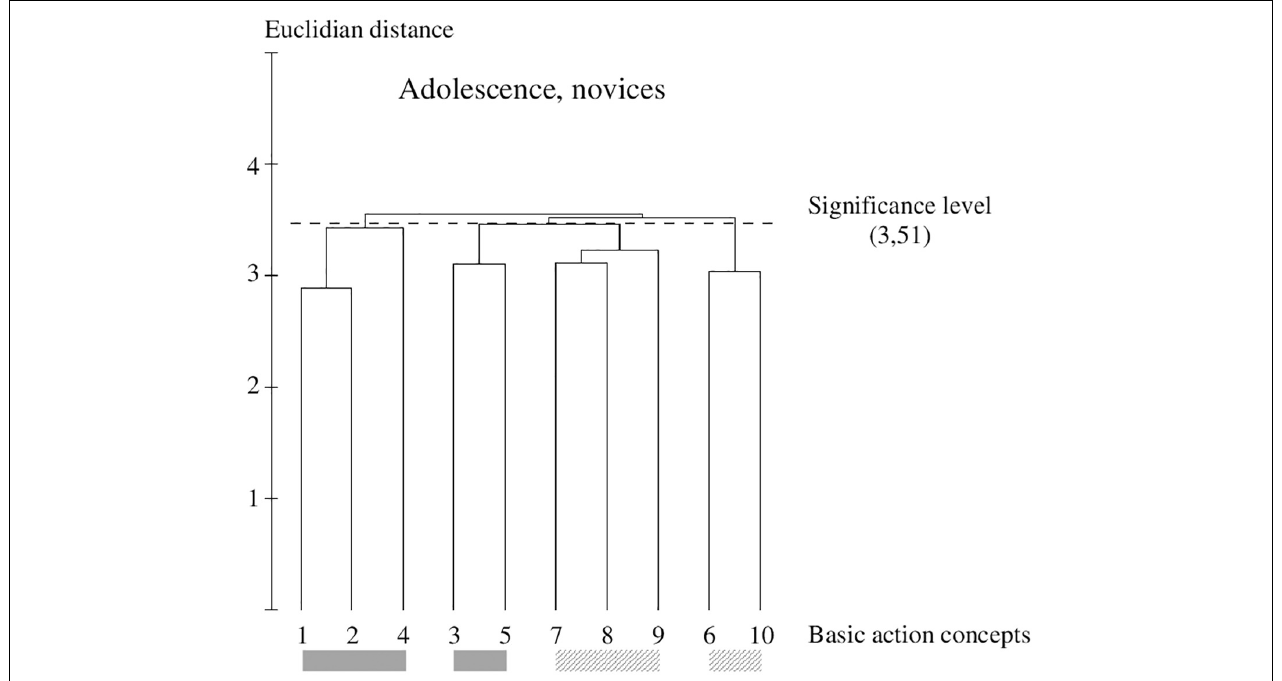
FIGURE 4 | Outcome of the hierarchical cluster analysis of novices within adolescents ( N = 18) displayed as a dendrogram. The dashed line clarifies the critical value of d crit = 3.51, which corresponds to a significance level of 5%. The BACs are marked with numbers among the dendrogram and highlighted with the gray solid bar (technically correct BAC) and diagonally striped bar (faulty BAC).